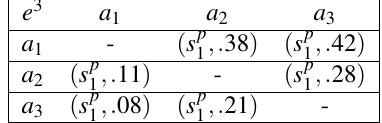
Table 11. Aggregated linguistic preference indexes for e 3 .